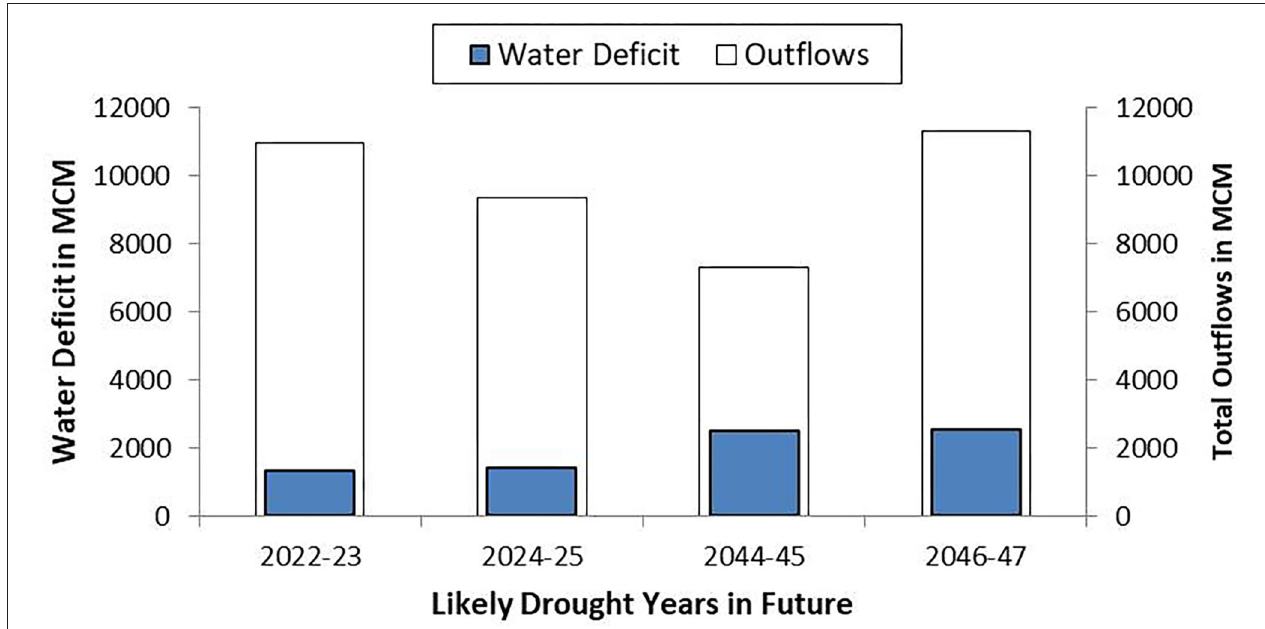
FIGURE 10 | Water balance during drought years in the study area as estimated by the WEAP